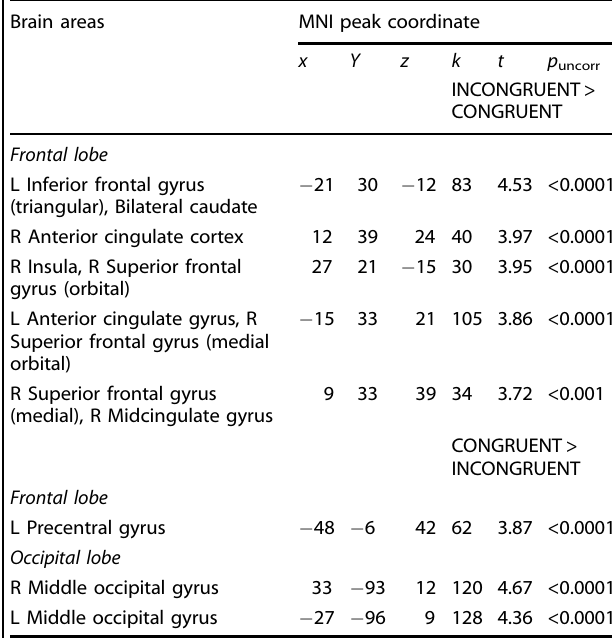
Table 4. Activation clusters for t -contrasts between congruent and incongruent statements in